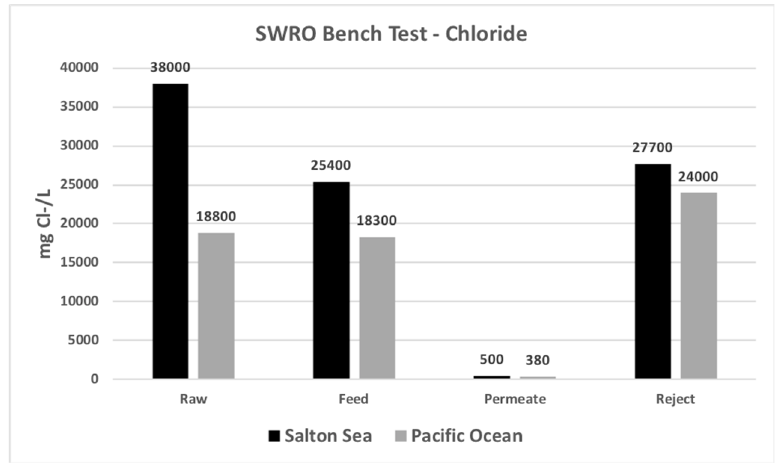
Figure 11. Chloride of raw water, SWRO feed, permeate, and reject flow.